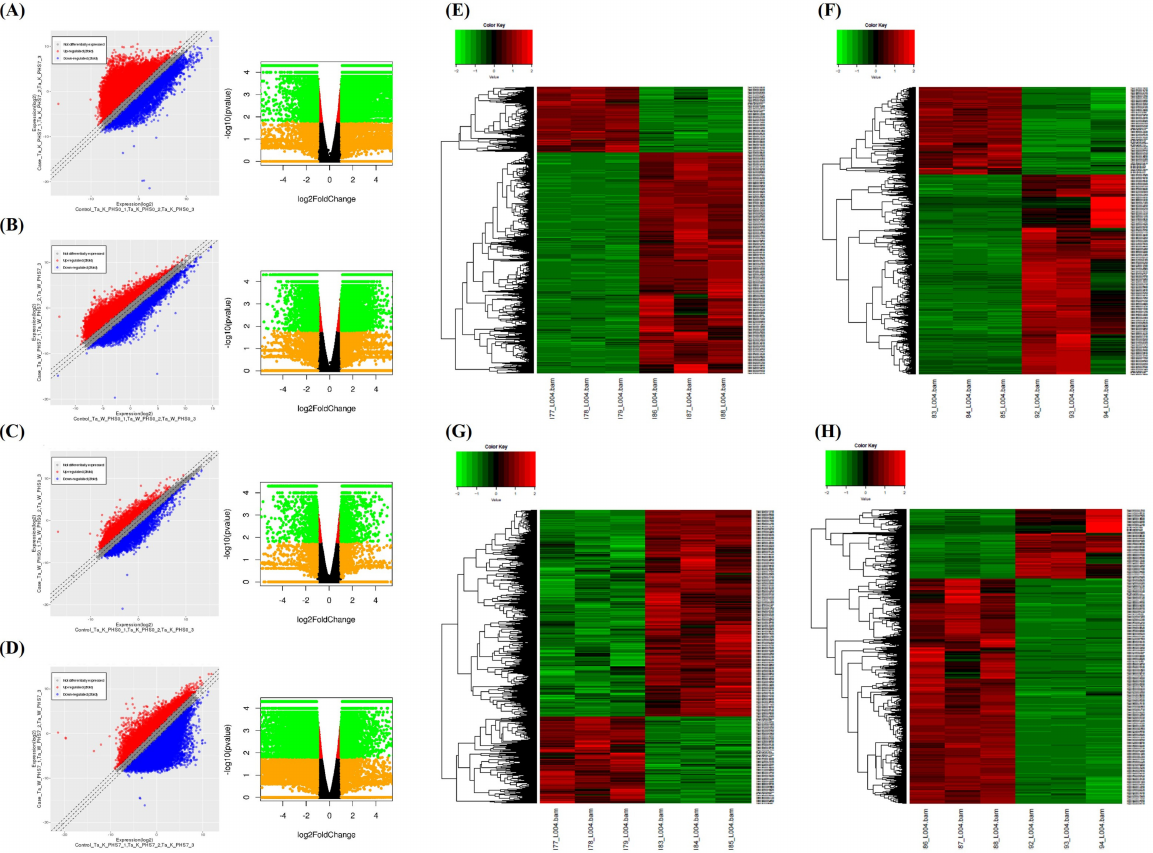
Figure 2. Scatter plot, volcano plot, and heatmap analysis of differentially expressed genes (DEGs) in K0 vs. K7, W0 vs. W7, K0 vs. W0, and K7 vs. W7 groups. ( A ) Scatter plot and volcano plot of the K0 vs. K7 group, ( B ) scatter plot and volcano plot of the W0 vs. W7 group, ( C ) scatter plot and volcano plot of the K0 vs. W0 group, ( D ) scatter plot and volcano plot of the K7 vs. W7 group, ( E )